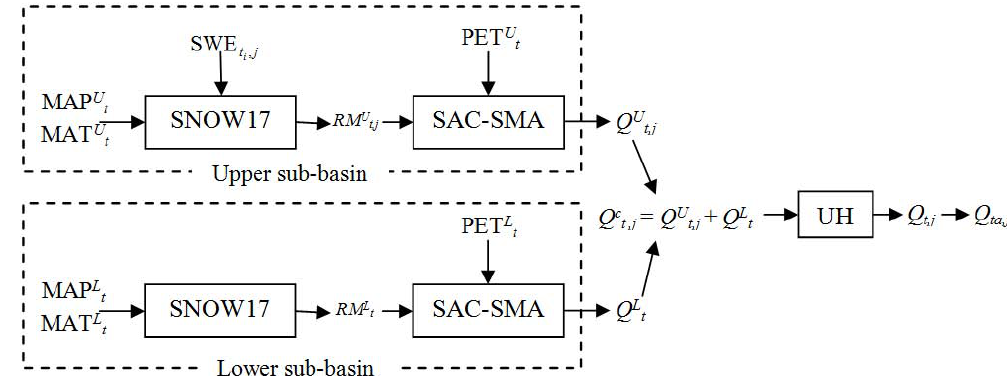
Fig. 4. Flowchart of modeling and assimilation (of areal SWE) procedures in generating ensemble daily streamflow. RM and Q represent rain plus snowmelt and streamflow, respectively; UH stands for unit hydrograph; t indicates time step ( t =1, 2, ..., T ; 6 hourly); ta is the daily time step aggregated from 6-hourly step; t i reprsents the measurement time when areal SWE is assimilated (refer to Fig. 2 for detailed assimilation procedure); j is the ensemble number ( j =1, 2, ..., N ); subscripts U and L denote variables for upper and lower sub-basins, respectively; subscript c designates the combined